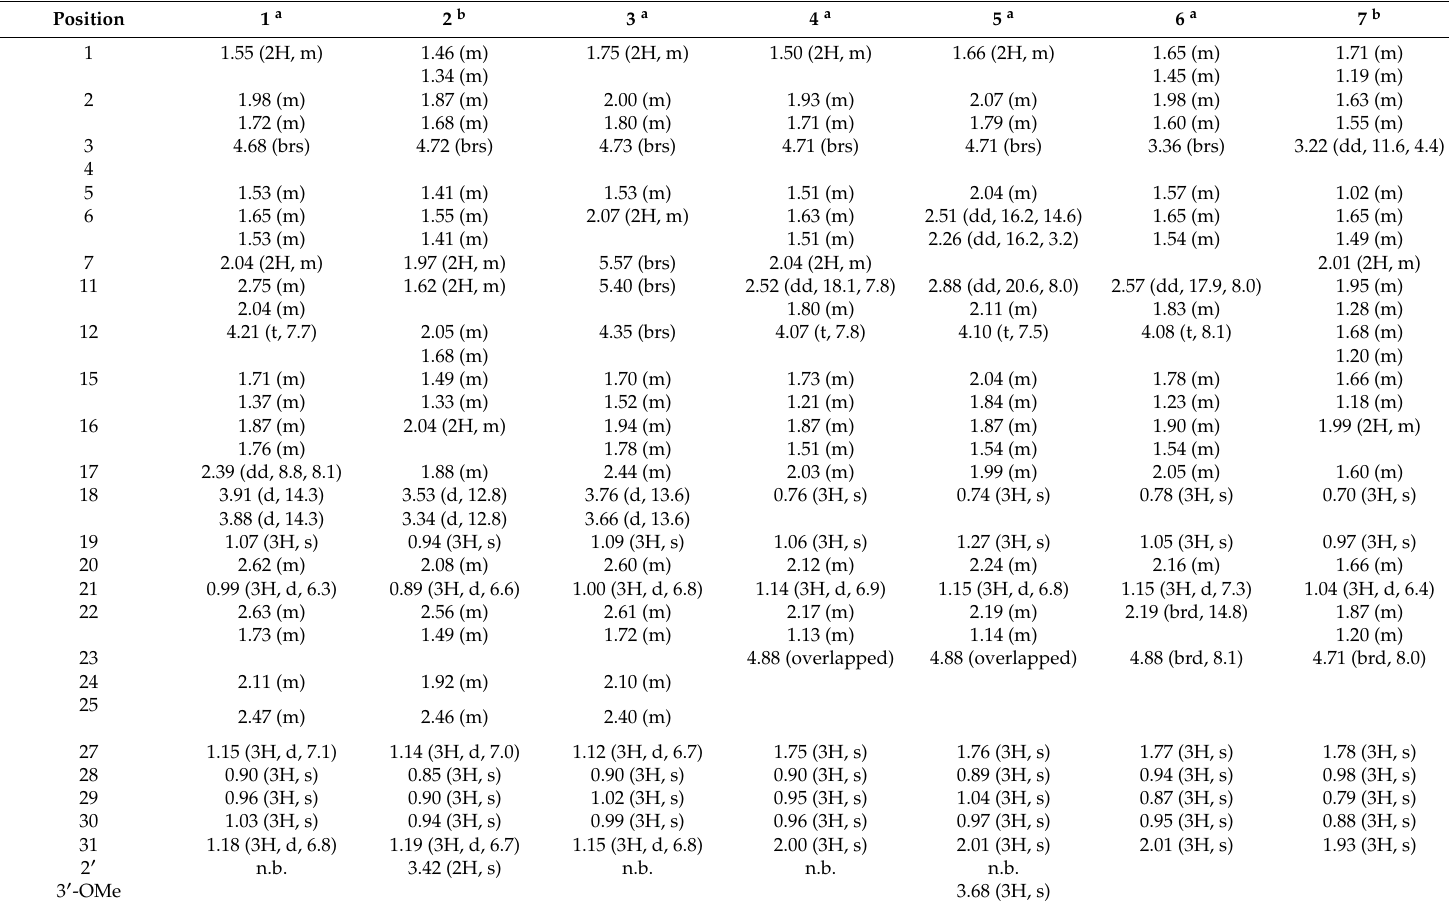
Table 1. 1 H-NMR spectroscopic data (400 MHz) for compounds 1 − 7 ( δ in ppm, J in